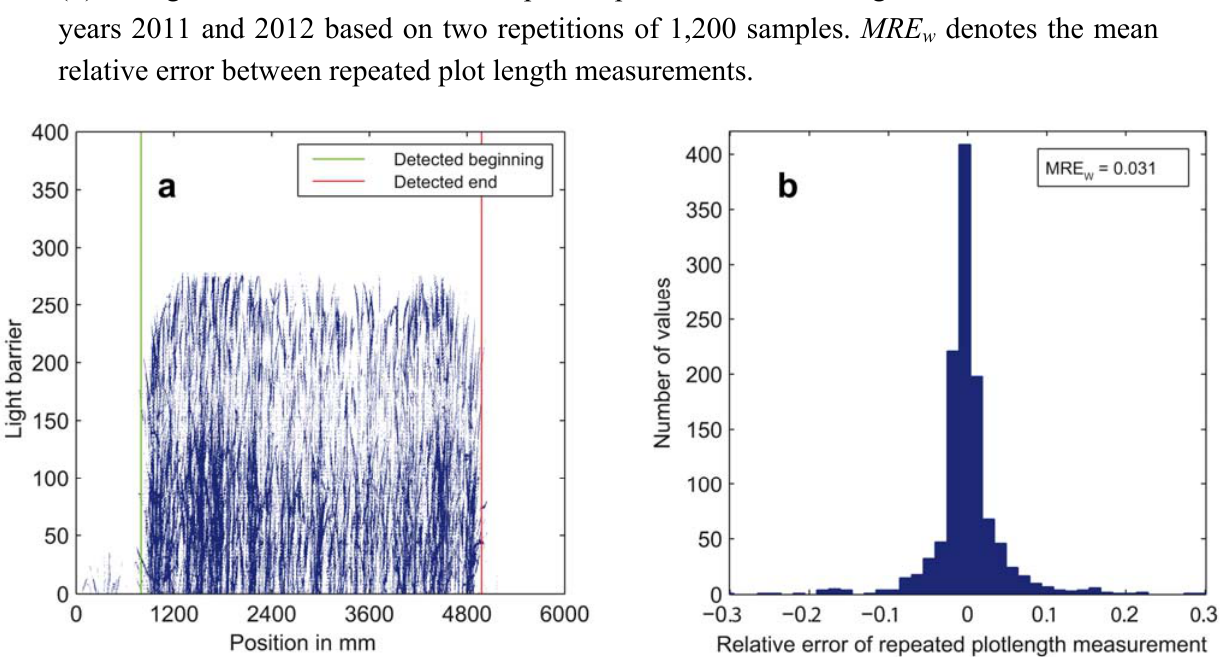
denotes the mean w